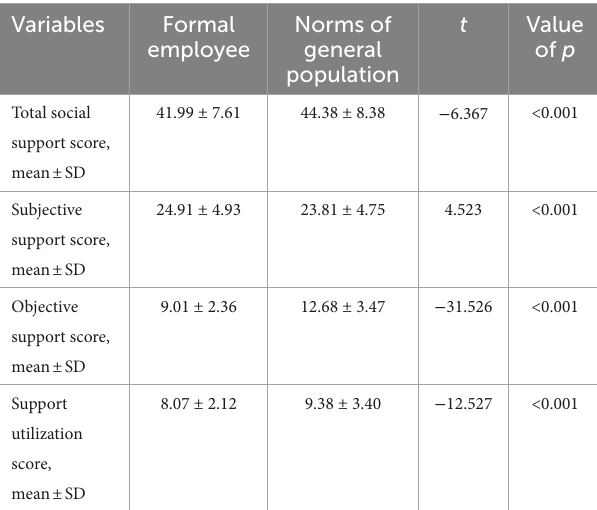
TABLE 2 The difference of social support scores between formal employee and the norms of Chinese general population.